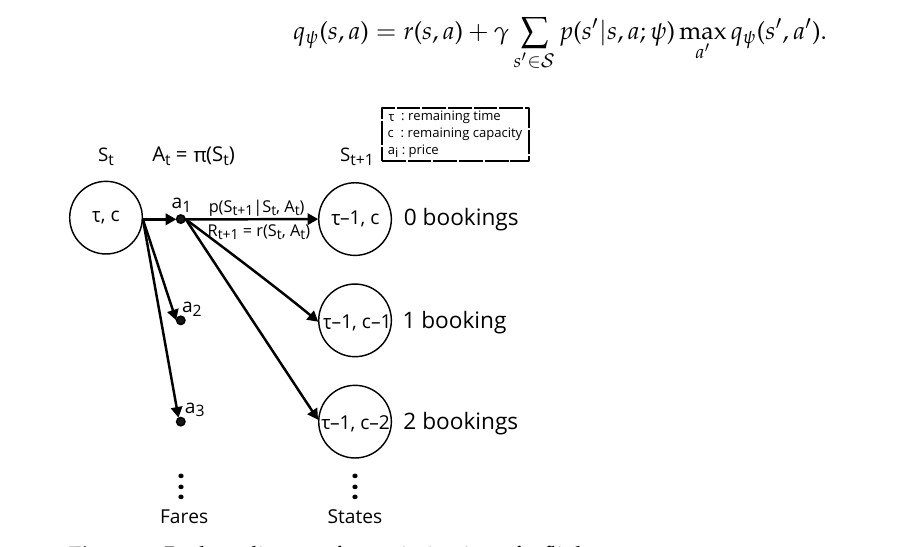
Figure 2. Backup diagram for optimization of a